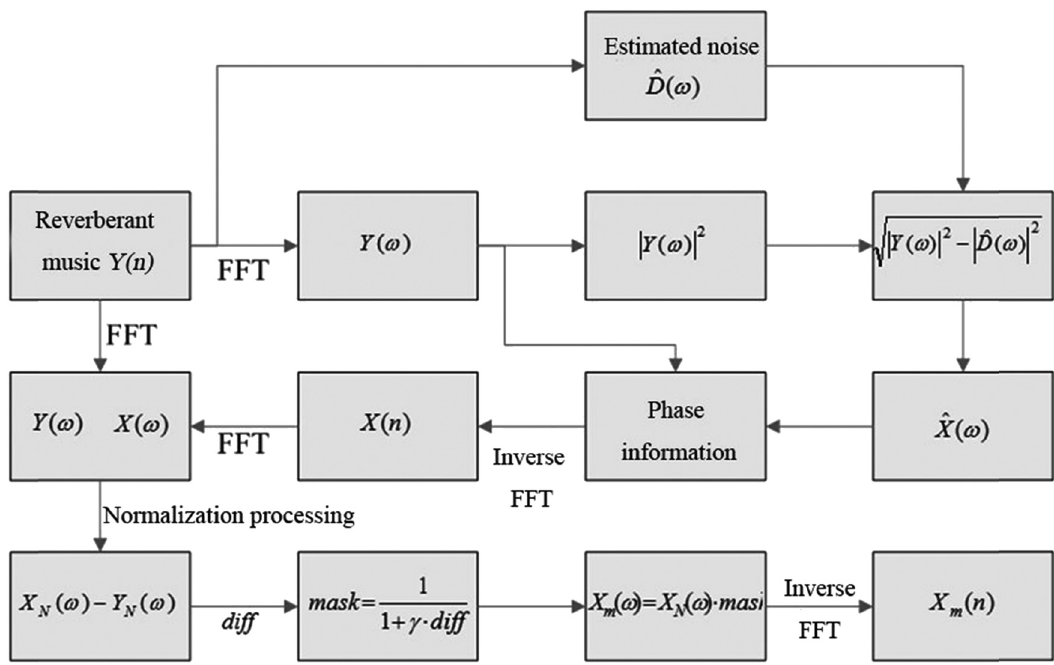
Figure 1: The process of de - reverberation and noise reduction of reverberant music by spectral subtraction based on the masking e ff